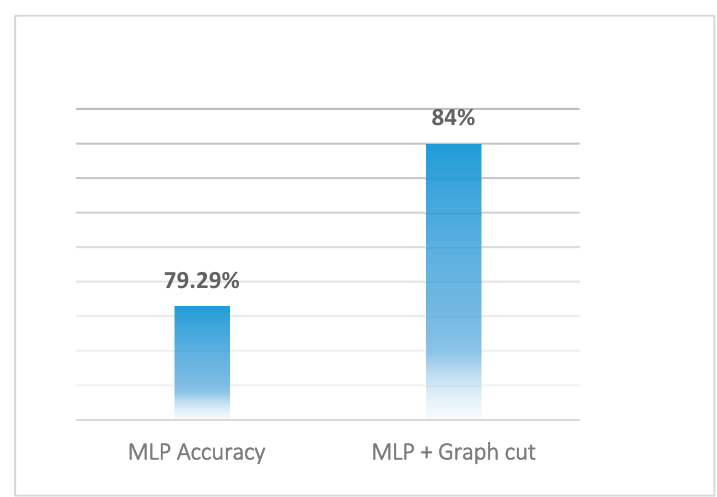
Figure 6. Testing stage performance.